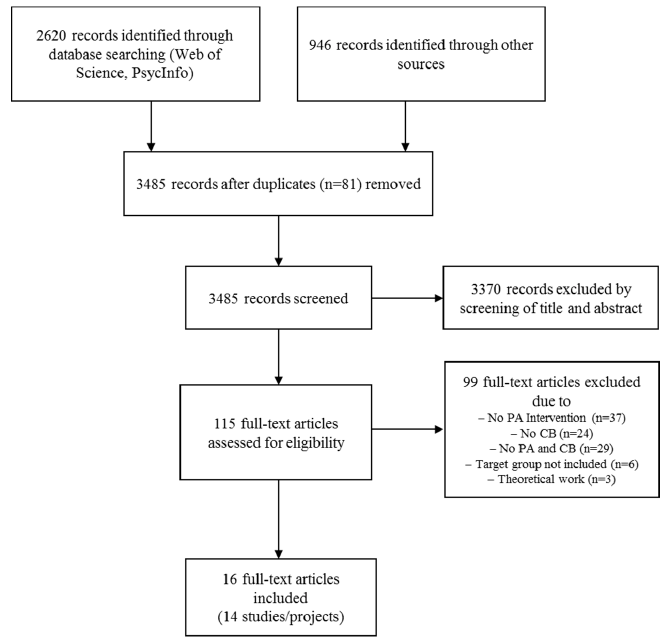
Figure 1. Flowchart of the literature search (PA physical activity; CB capacity building).